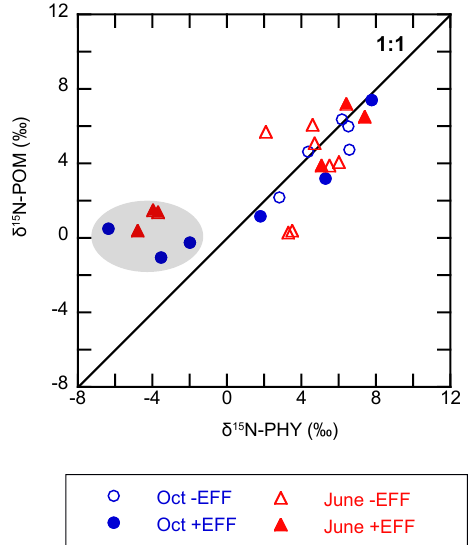
Figure 4. Comparison of δ 15 N-POM and δ 15 N-PHY for October and June experiments for parcels that received effluent ( + EFF) and parcels that did not receive effluent ( − EFF). The grey circle in- dicates the six + EFF samples collected >20h downstream of the